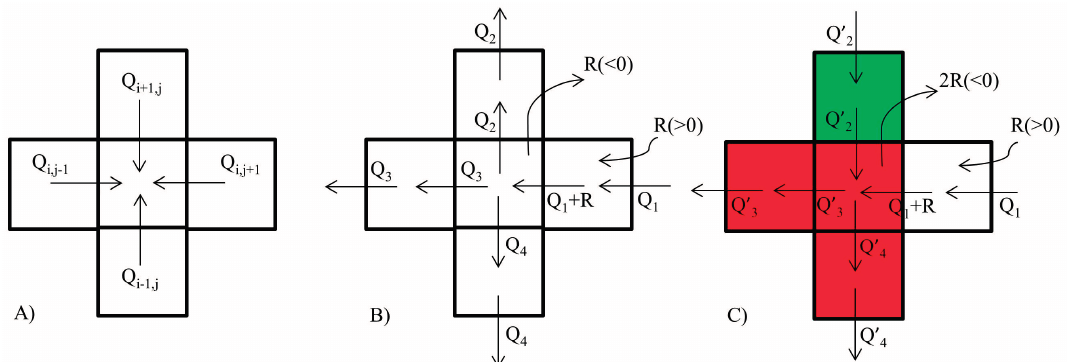
Figure 2. ( A ) Flow scheme utilized for computing the recharge/discharge index; ( B ) example of flow scheme with a recharge R in the eastern cell and a discharge R in the center cell; ( C ) example of flow scheme with a recharge R in the eastern cell and a discharge 2 R in the center cell under the hypothesis that only the northern cell is able to increase its Q out flux for sustaining the increase in the discharge rate in the center